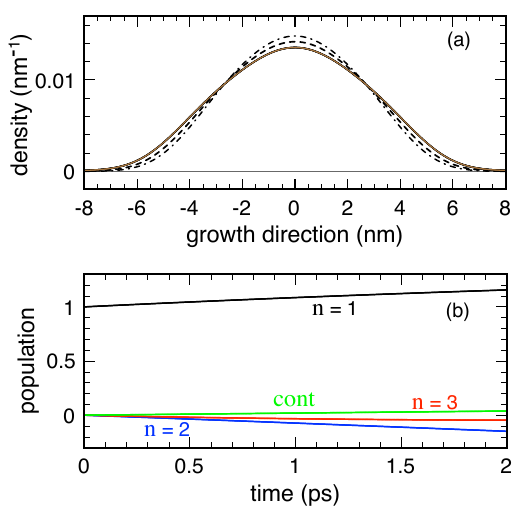
Figure 7. ( a , b ) The same as in Figure 6 but considering as initial state the thermal-equilibrium state n = 1. Reprinted from